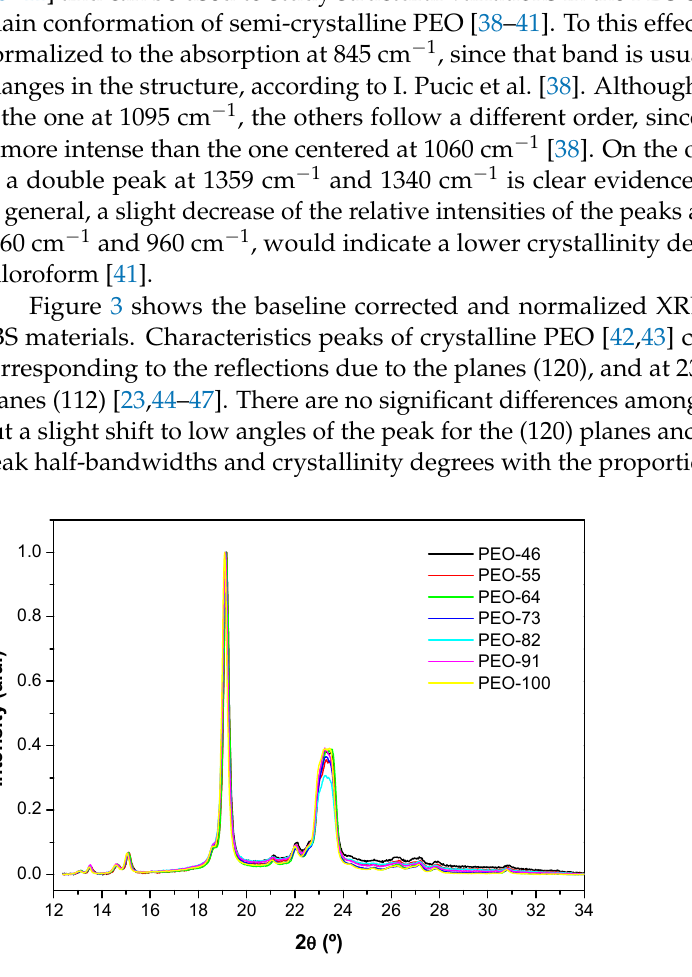
Figure 2. ATR-FTIR spectra of the blow spun PEO-based obtained from 10% wt solutions at different compositions Chl:Ac.